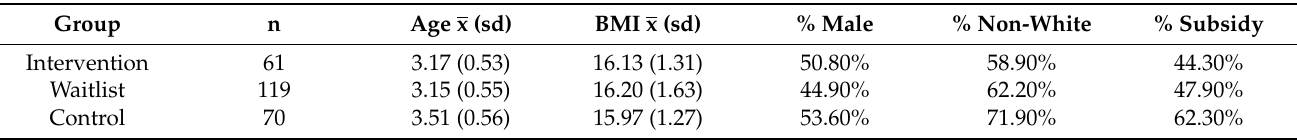
COLEAFS center-level characteristics at baseline, by intervention (I), waitlist (delayed intervention) (W), and control centers